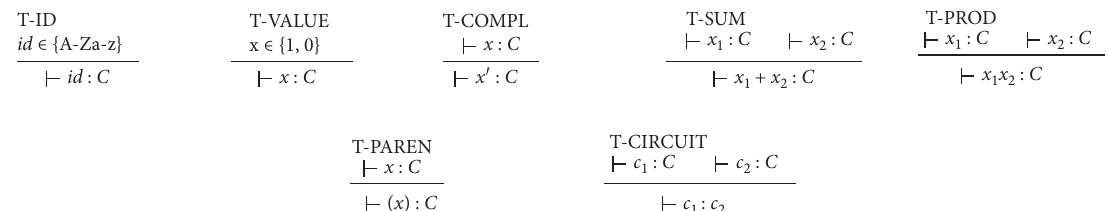
Figure 11: Rules for checking logic circuits in the input description